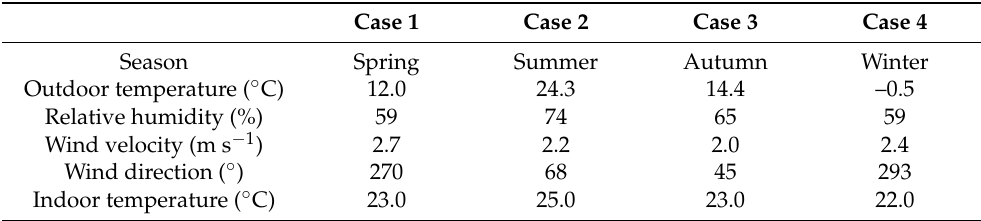
Table 1. Simulation input data for the outdoor and indoor environmental conditions.